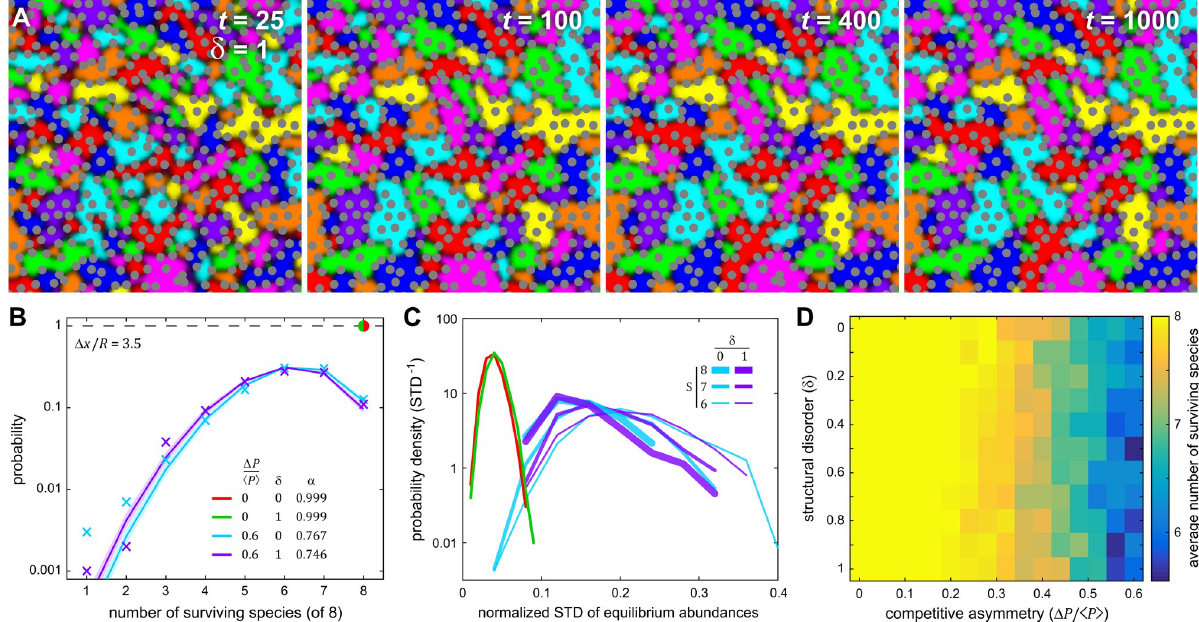
Fig 3. Species coexistence is robust in the presence of structural disorder. (A) Similar to Fig 1C, these panes show the time evolution of an 8-species system where steric pillars were randomly perturbed from a triangular lattice ( δ = 1). From random initial conditions the system rapidly equilibrated to a stable configuration that supported all 8 species. (B) Simulations were performed to measure the probability distribution for the number of long-term coexisting species under four conditions (1,000 each): high and low competitive asymmetry and high and low structural disorder. The structural scale was held fixed. Without competitive asymmetry all species survived in all simulations, with or without disorder (red/green dot). With high competitive asymmetry, the probability distributions spread across all possible numbers of species with relatively little distinction between ordered and disordered systems (colored X’s). Those distributions were well-described by a modified binomial distribution (solid lines) with an ensemble-average single-species survival probability of α ~ 0.75. The distributions exhibit larger variation where there are less data (i.e. lower probabilities, from one to three surviving species). (C) For each simulation, the normalized standard deviation (NSD) in equilibrium abundances was measured, and those values are shown here as a histogram for each of the four conditions. In the absence of competitive asymmetry (green, red), the mean NSD was low (~0.05 on maximum scale of 1). When competitive asymmetry was high, we examined the NSD for all simulations that had 6, 7, or 8 surviving species (cyan, purple). All of those distributions were significantly wider and had significantly higher mean NSD’s, meaning that competitive asymmetry increases the variation in species abundance at equilibrium, regardless of how many species stably coexist. (D) We compared the average number of surviving species across a range of competitive asymmetry and disorder (0 � δ � 1). Those distributions showed little variation with disorder and, as a function of competitive asymmetry, had a mean pairwise correlation of 0.97 (see S4 Fig). Thus our data suggest that structural scale has a stronger effect than disorder (at least in this portion of parameter space). In all simulations L = 150, h P i = 0.25, and R =